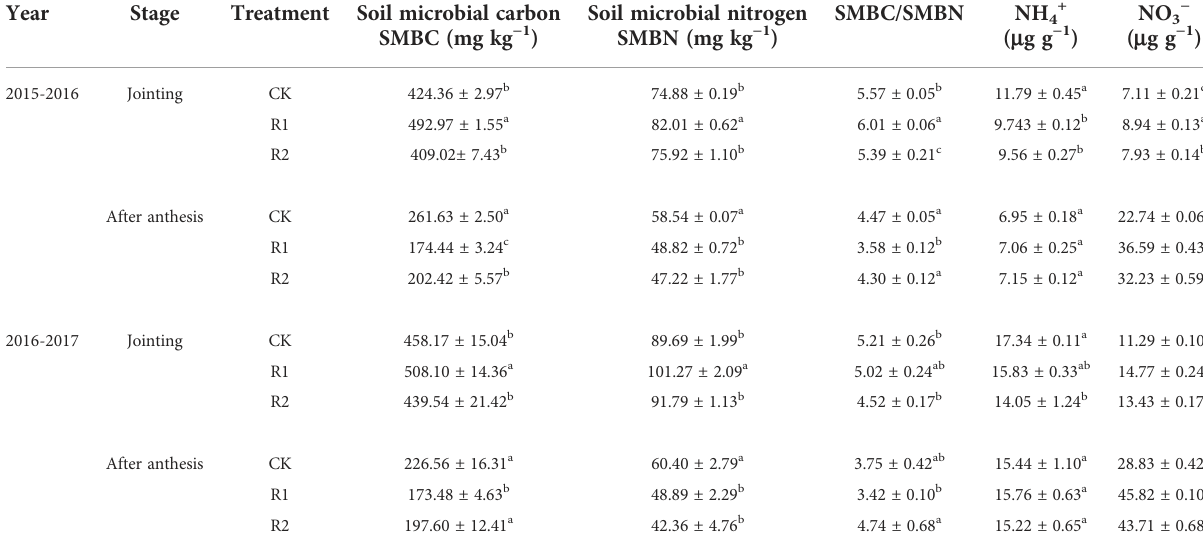
TABLE 5 Microbial biomass and inorganic nitrogen content in soil under different row spacing treatments in two years.